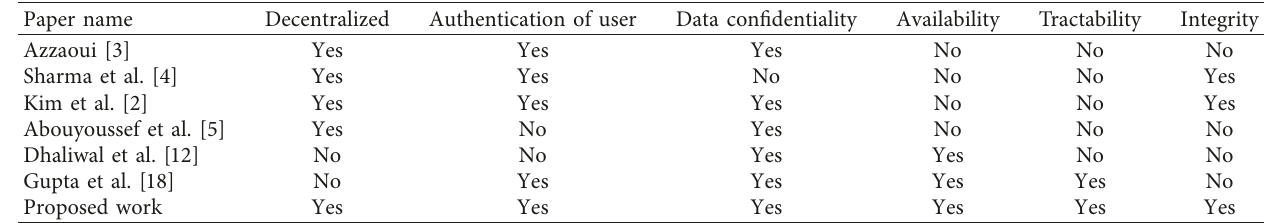
Table 3: Overall comparison of existing work with proposed